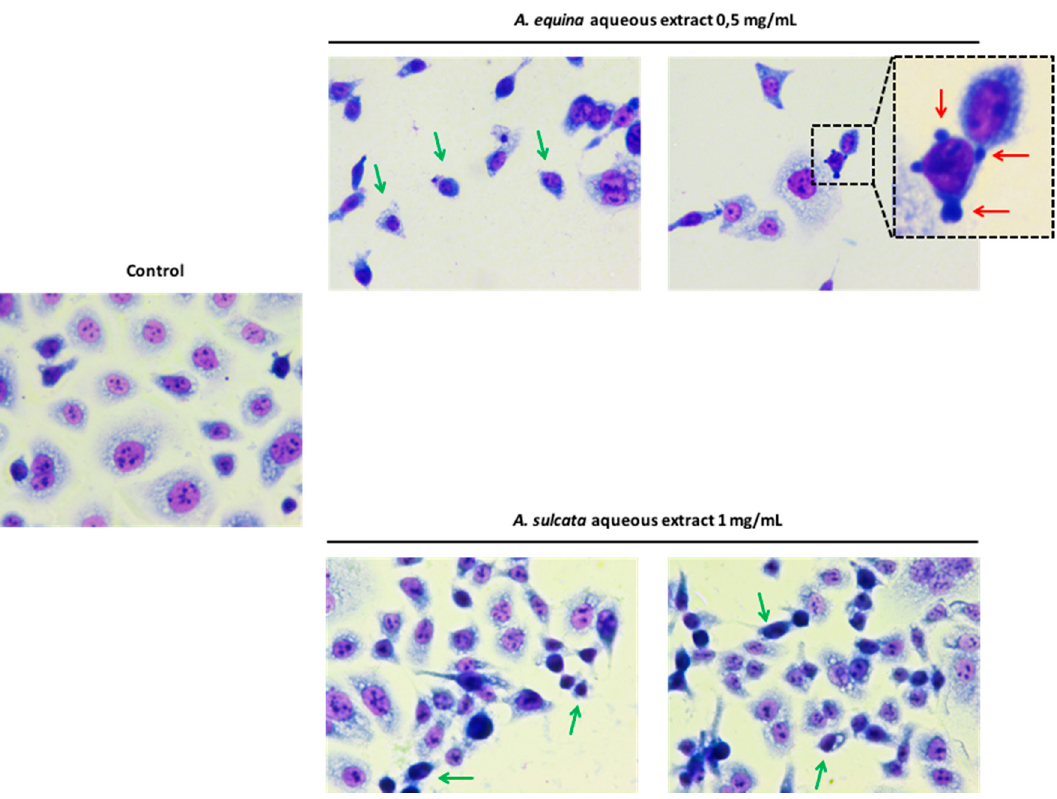
Figure 7. Morphological assessment of AGS cells (control vs. treatments, 24 h of incubation) by Giemsa staining. Green arrow: condensed chromatin; red arrow: apoptotic bodies. Magnification 400×.